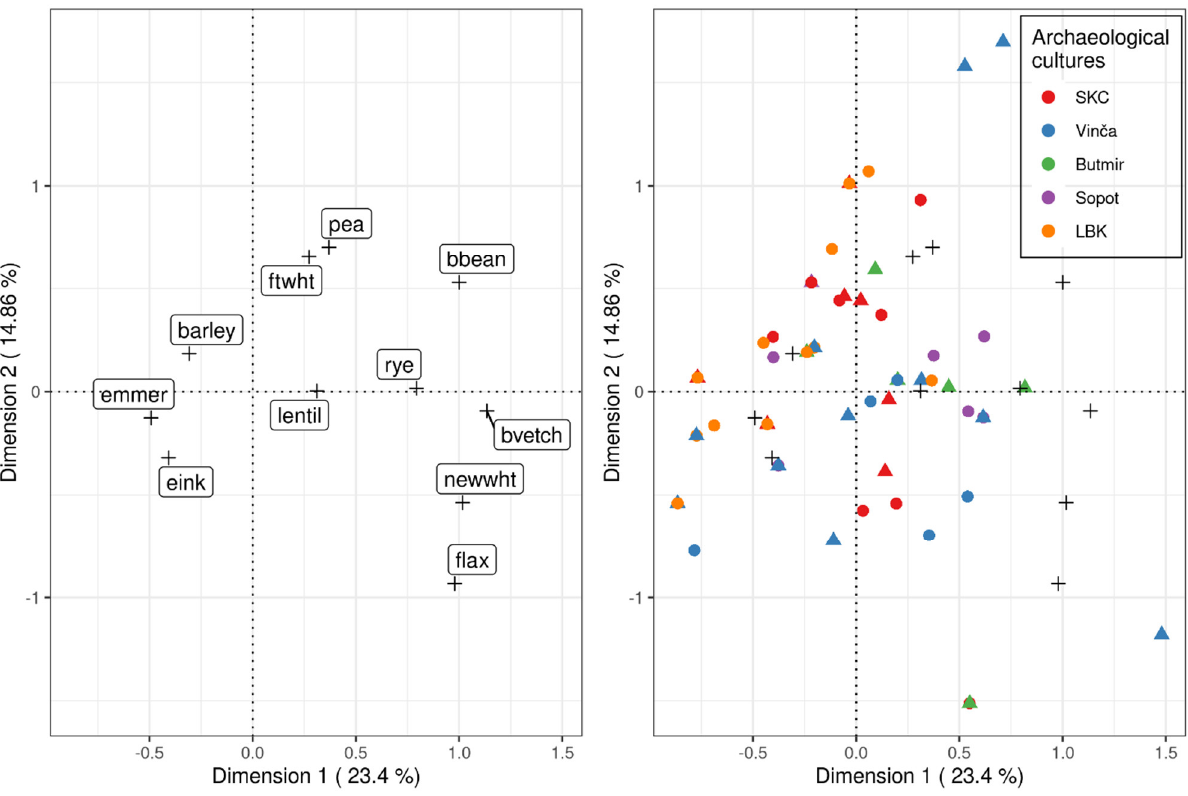
Figure 7. Correspondence analysis plots of crops and sites (triangles denote Pannonian sites, circles denote Continental sites; see Table 1 for full taxa names). Table 1. Vernacular names and Latin binomials of the taxa included in the correspondence